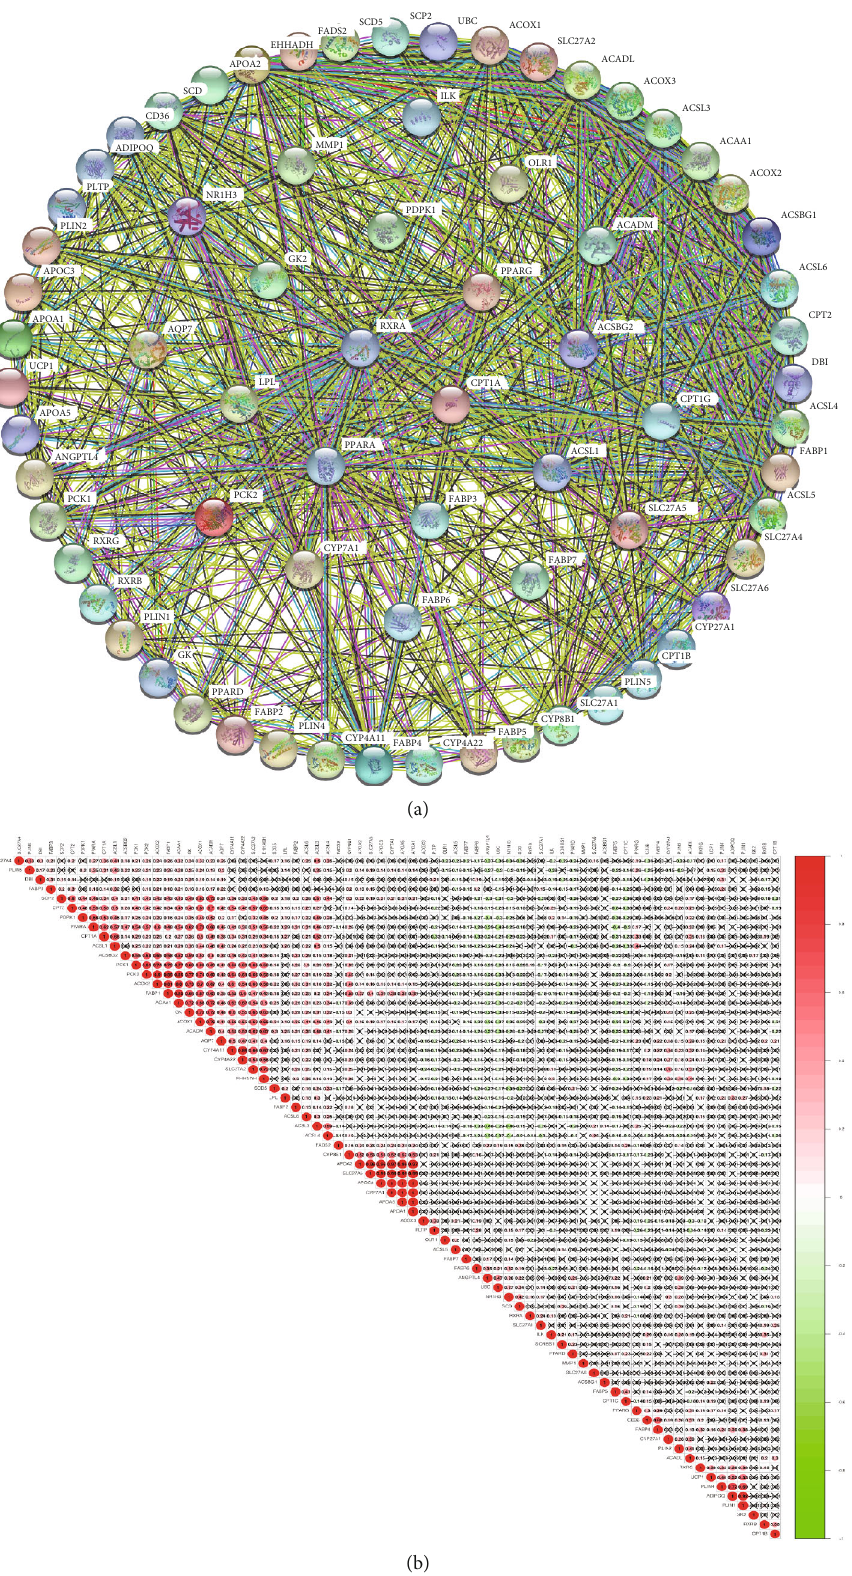
Figure 2: Interactions and correlations between PPAR pathway molecules. PPI network (a) and coexpression analysis (b) between PPAR pathway-related